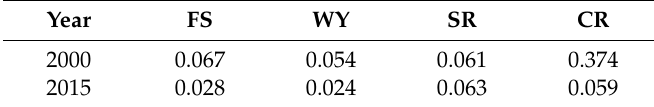
Table 3. The mean of supply–demand ratio for four ES in the